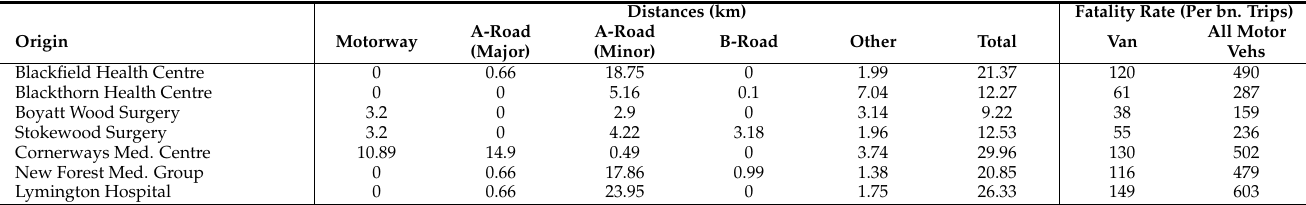
Table 2. Distances by road class and trip fatality rate for each road journey. Destination is Southamp- ton General Hospital in all cases. Distances (km) Fatality Rate (Per bn. Trips)